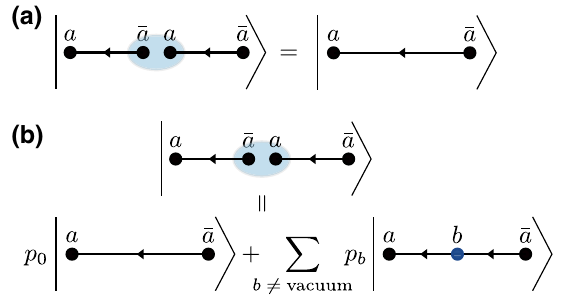
FIG. 8. The manipulation of Abelian and non-Abelian anyons. (a) Two separate Abelian anyons a and ¯ a can be created by a sequence of multiple local anyon-antianyon pairs. The inter- mediate quasiparticles fuse to the vacuum. (b) If a and ¯ a are non-Abelian anyons, the transport of the anyon is no longer equivalent to local pair creation and pair annihilation of a and ¯ a . The fusion yields a superposition of the vacuum and some other nontrivial anyon species b , with amplitudes p b .